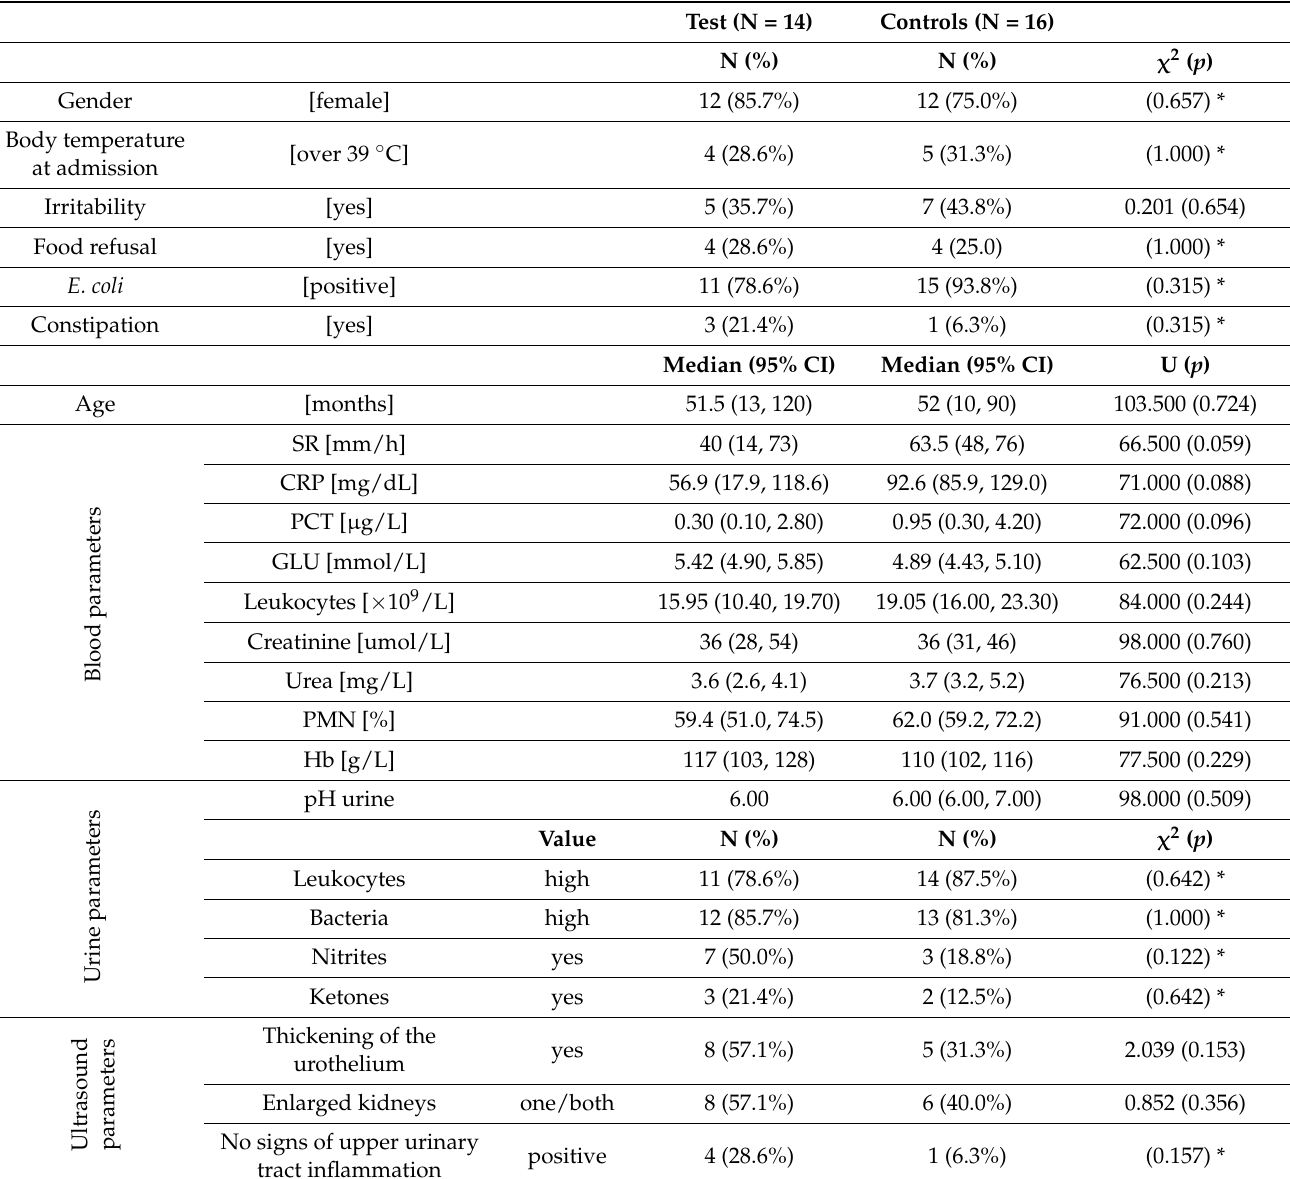
Table 1. Demographic, clinical, laboratory, and ultrasound parameters measured upon admission in the test and control